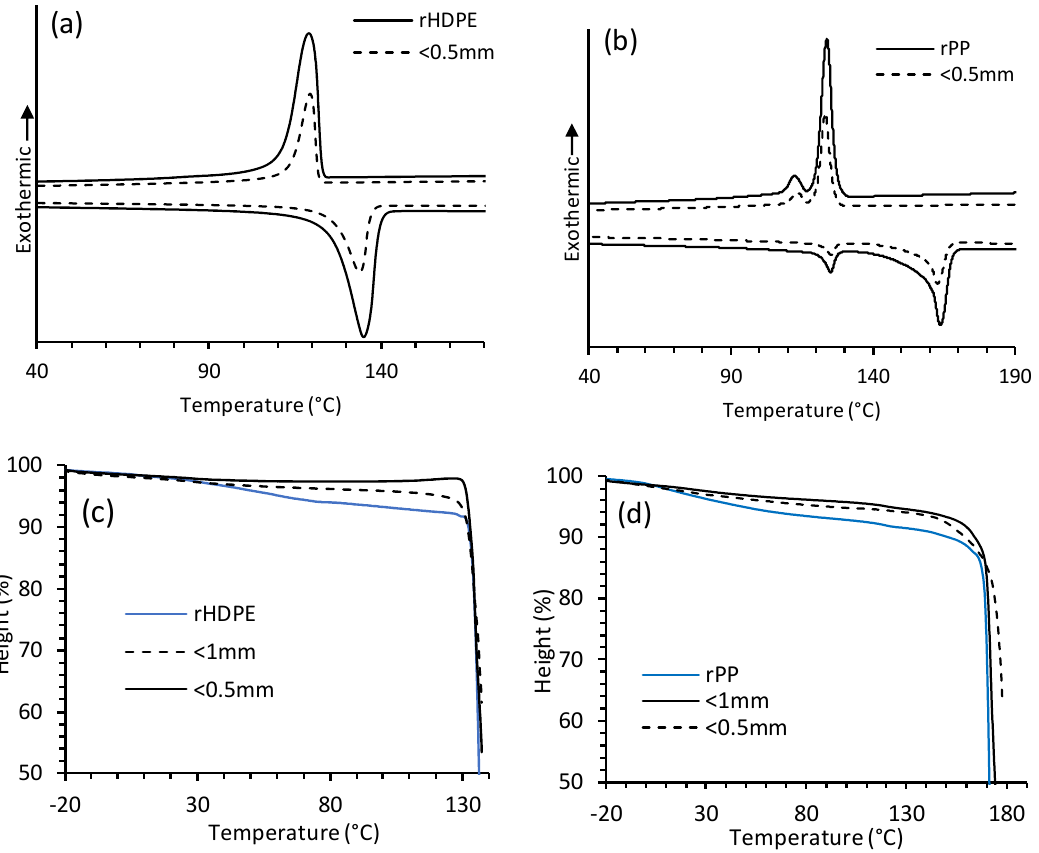
Figure 2. Differential scanning calorimetry (DSC) thermograms of recycled polyolefin composites for ( a ) recycled high-density polyethylene (rHDPE), ( b ) recycled polypropylene (rPP), and thermomechanical analysis (TMA) thermograms for ( c ) rHDPE and composites ( d ) rPP and composites. Table 2. Thermogram Peak data for polyolefins and corresponding rice hull composites.